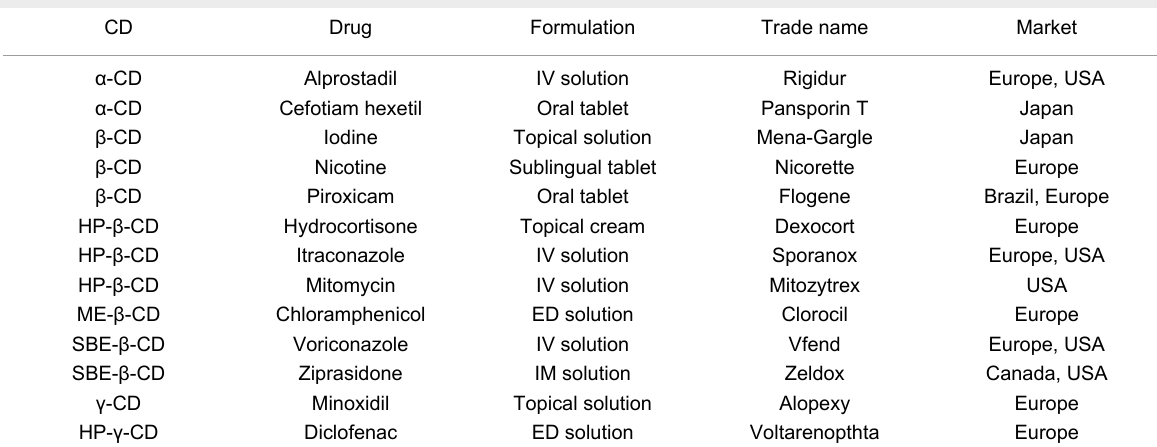
Table 2: Some marketed pharmaceutical formulations with CD.